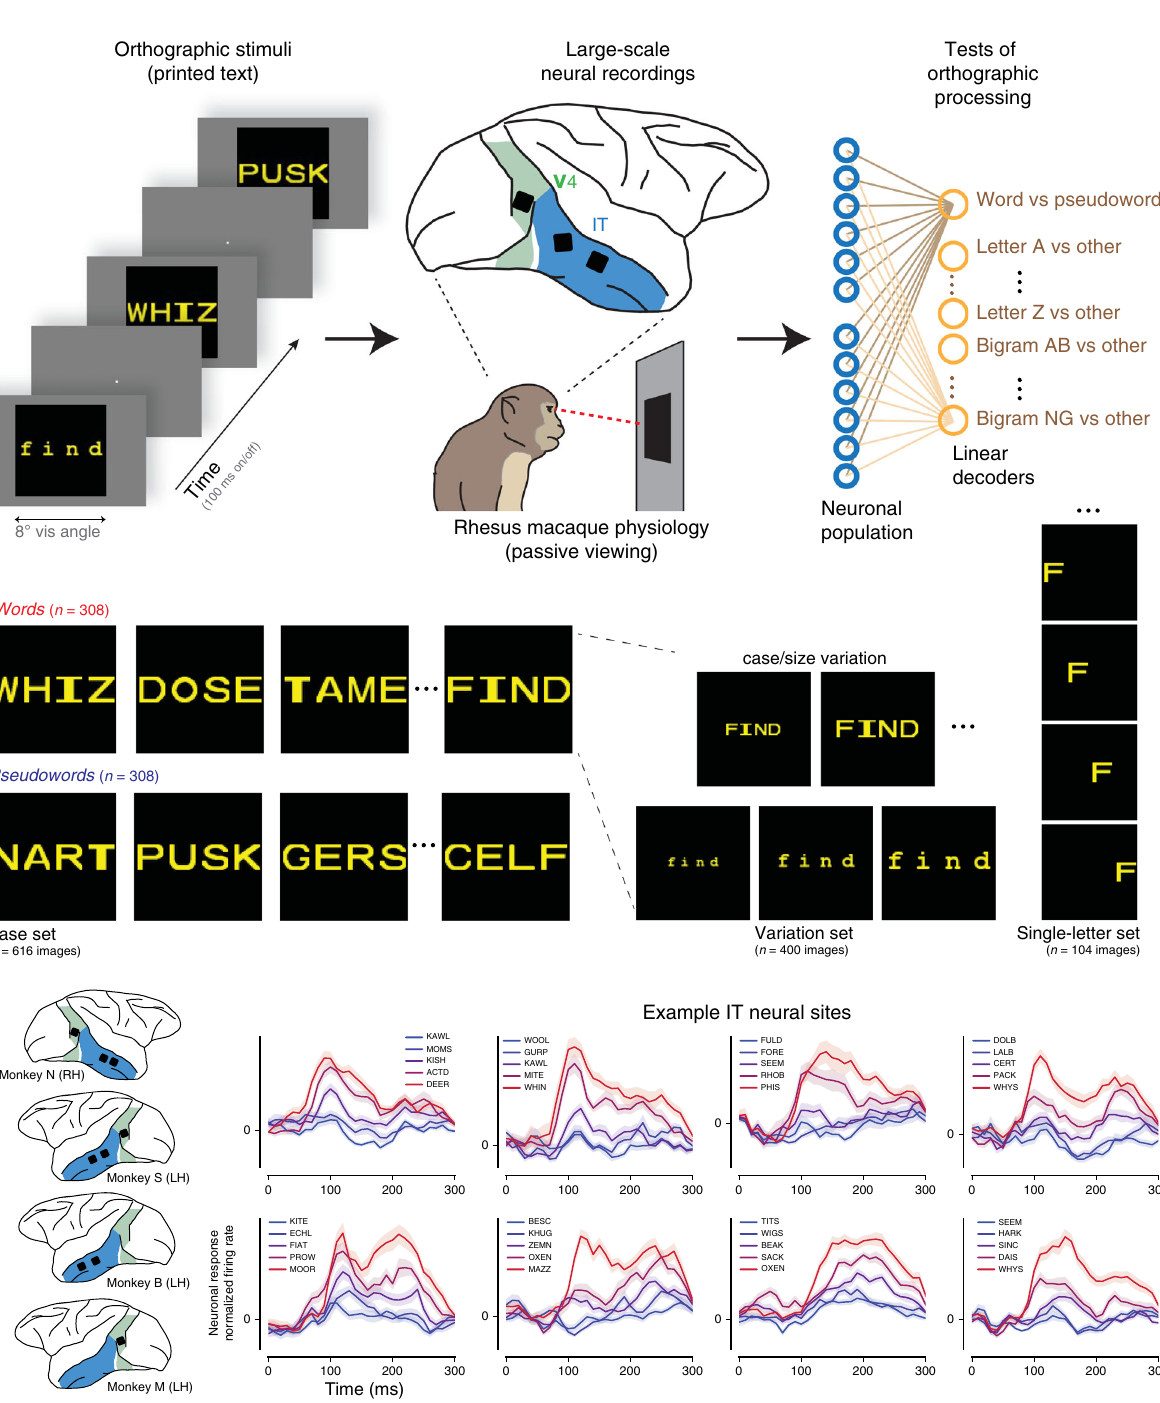
Fig. 1 Conceptual schematic of experiment. a We recorded the activity of hundreds of neural sites in cortical area IT while monkeys passively viewed images of orthographic stimuli. (As a control, we also recorded from the dominant input to IT, area V4.) We then tested the suf fi ciency of the IT representation on 30 tests of orthographic processing (e.g., word classi fi cation, letter identi fi cation, etc.) using simple linear decoders. b Example visual stimuli. Images consisted of four-letter English words and pseudoword strings presented in canonical views, as well as with variation in case (upper/lower) and size (small/medium/large), and single letters presented at four different locations. c Responses of example IT neural sites. The approximate anatomical locations of implanted arrays are shown on the left for each monkey. Example neural activity in response to stimuli are shown for eight example neural sites in IT. Each trace corresponds to responses (mean over repetitions) to fi ve example images chosen to illustrate the full range of evoked response; the color of each trace corresponds to the response magnitude, and is not indicative of whether a string corresponded to a word or pseudoword. Shaded areas correspond to SE of the mean response, over stimulus repetitions ( n > 30 repetitions per